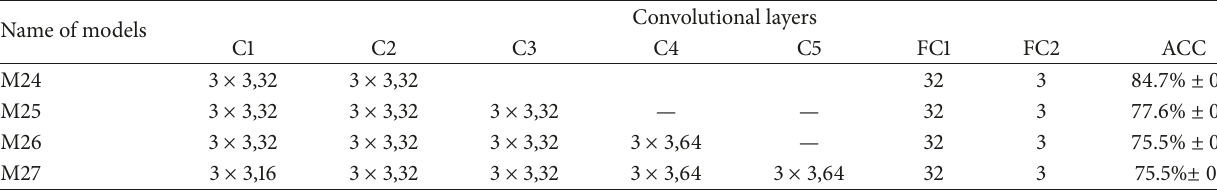
Table 3: Architecture of single-input models.